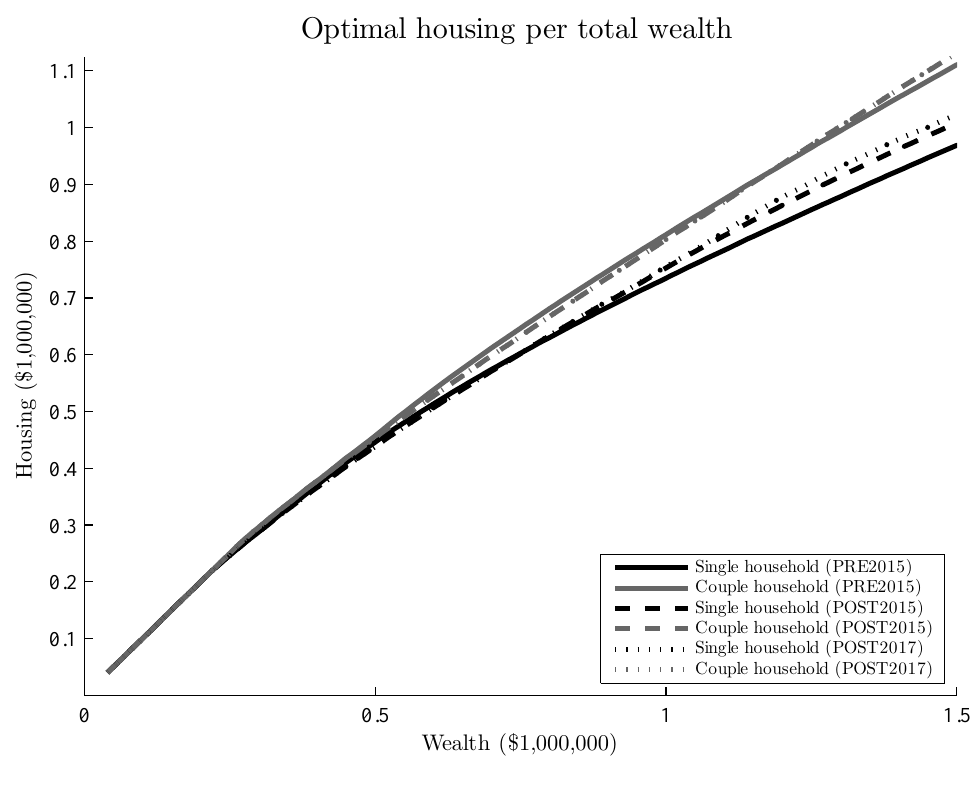
Figure 6. Optimal housing allocation given by total wealth W for single and couple households, under the three policy scenarios with the low return ( µ =